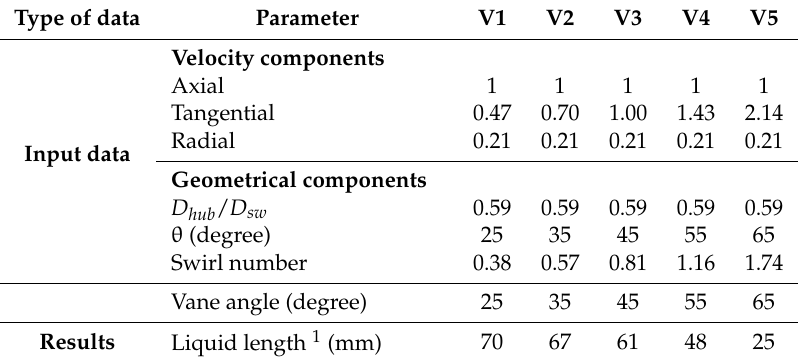
Table 3. Velocity components for inlet air stream at different swirl cases, geometry